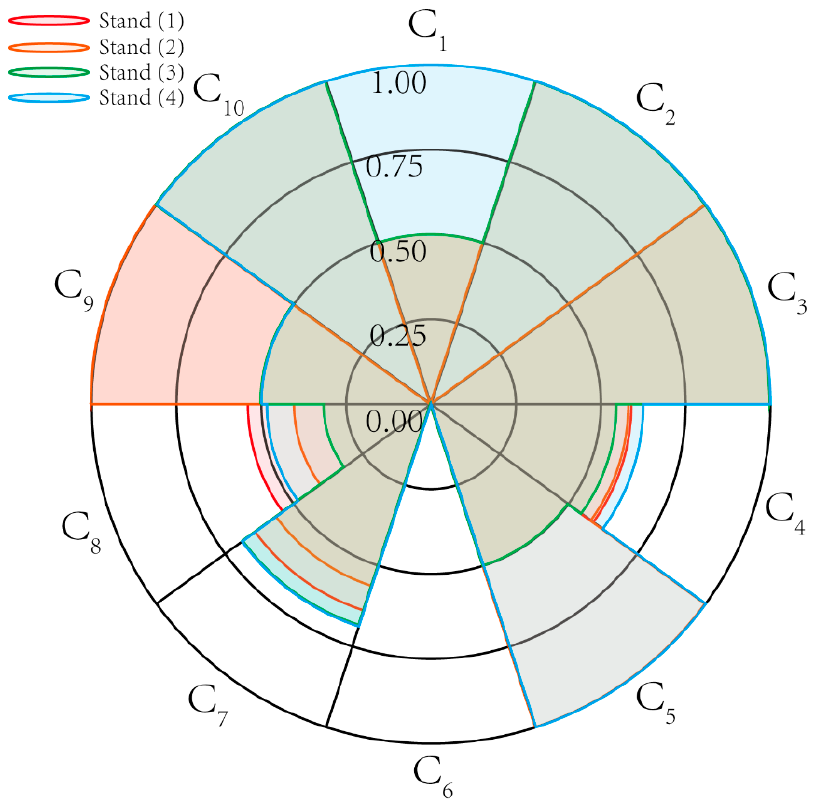
Figure 7. New unit circle of Q. aliena var. acuteserrata broad-leaved mixed forest (stands (1) and (2)) and P. koraiensis broad-leaved mixed forest (stands (3) and (4)).